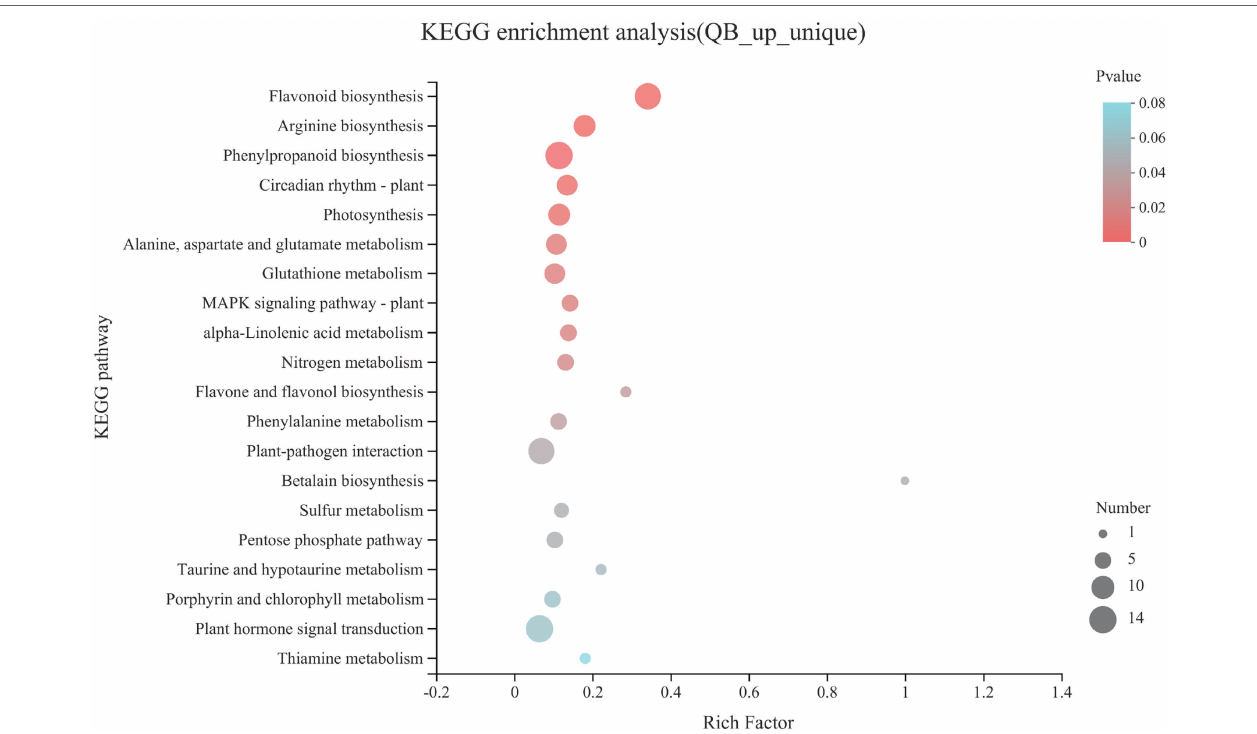
FIGURE 4 | KEGG pathway enrichment analysis of gene sets including upregulated DEGs and uniquely expressed genes in QB-G. The ordinate represents the pathway name, and the abscissa is the rich factor; the larger the rich factor is, the greater the degree of enrichment. The size of the circle indicates the number of genes enriched in pathway, the circle color represents value of p